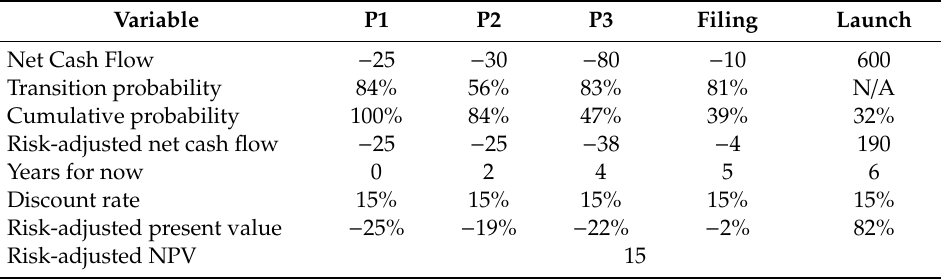
Table 5. Cases of calculating r-NPV.